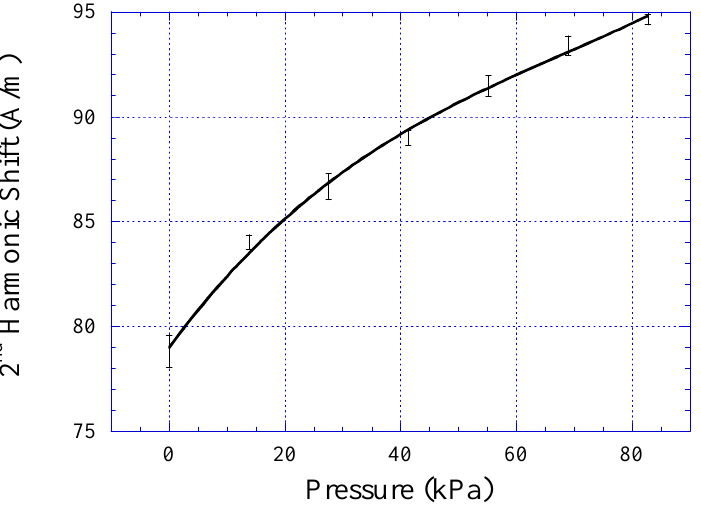
Figure 5. The 2 nd order harmonic shift of the sensors at varying pressures from 0 to 83 kPa (12 psi).